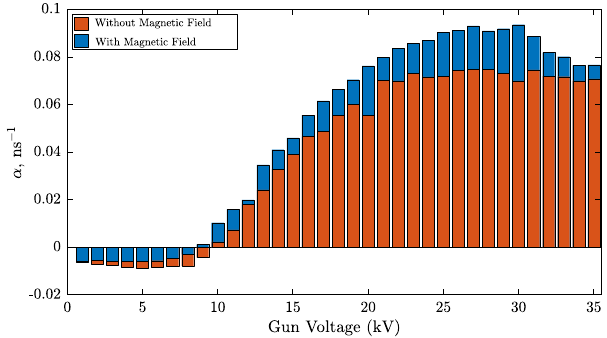
FIG. 8. Exponential growth rate of electron avalanche α as a function of accelerating voltage in the SRF gun simulated by CST PS with (blue) and without (orange) external solenoidal